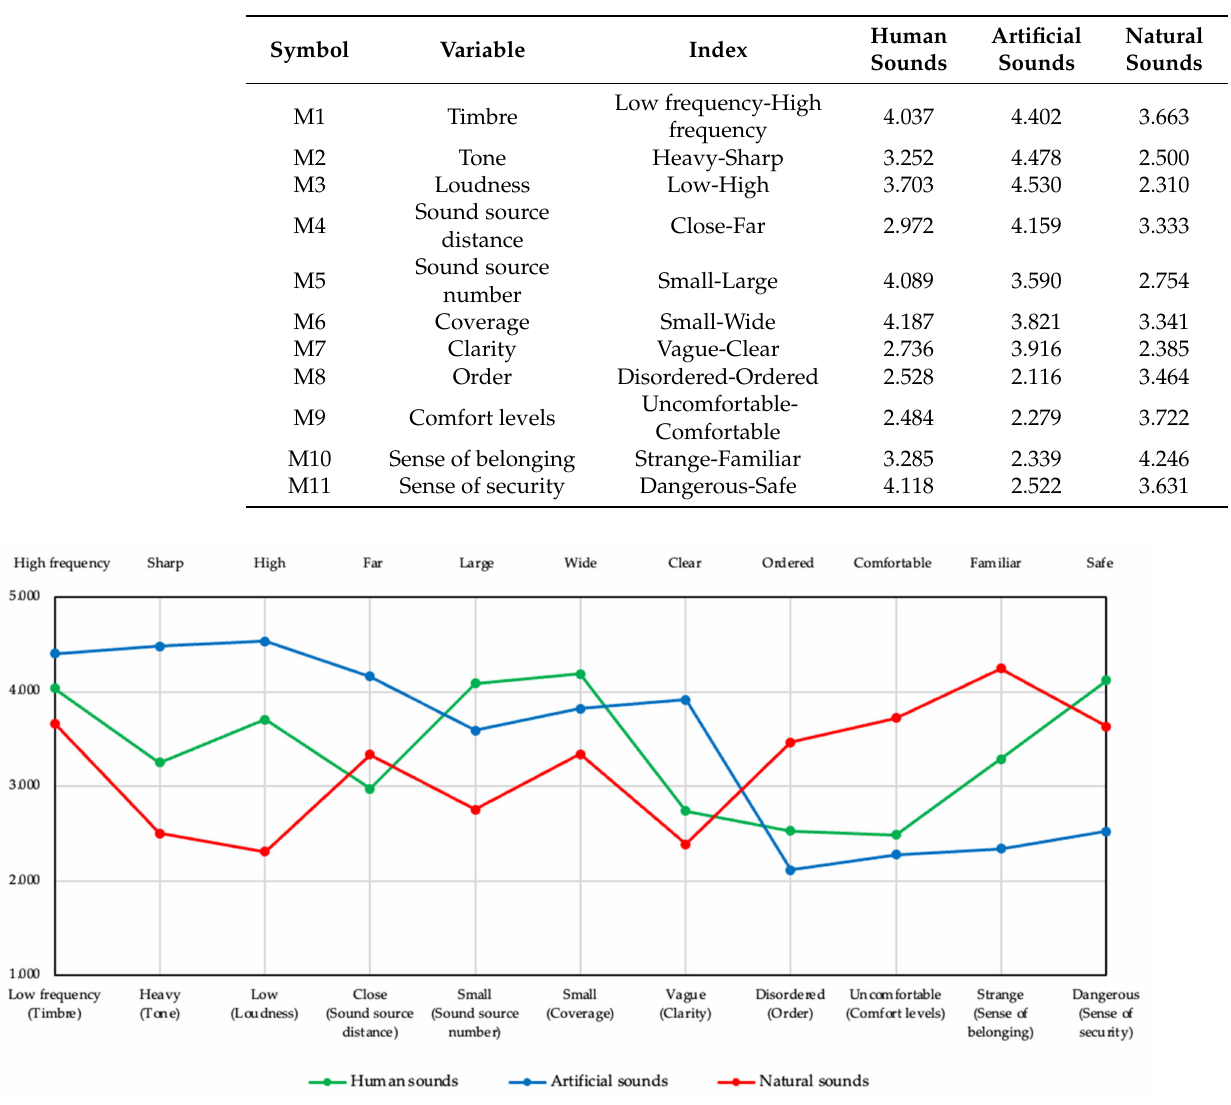
Figure 8. The SD evaluation curve of this study. The figure was created by the